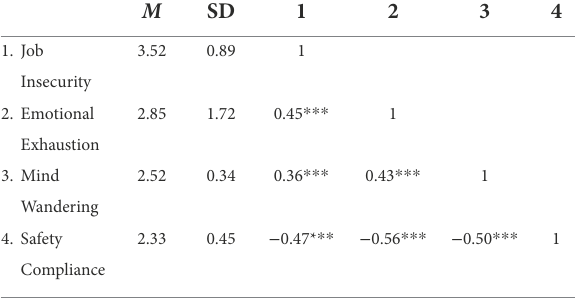
TABLE 1 Descriptive statistics and correlation analysis of main variables ( N =